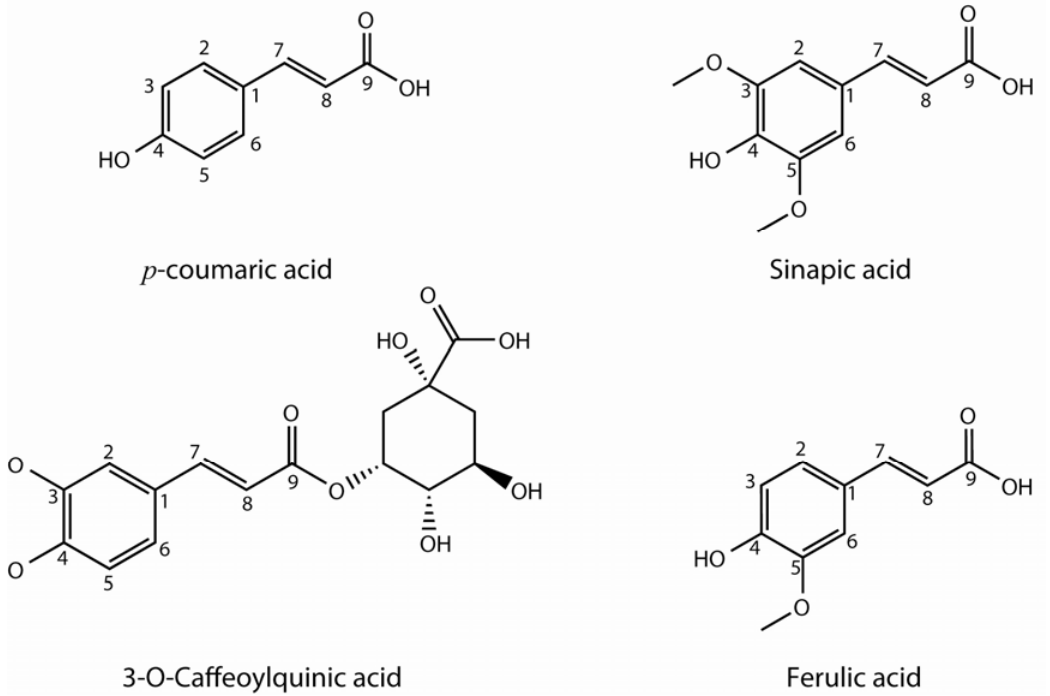
Figure 2. Hydroxycinnamic acids found in vegetable Brassica